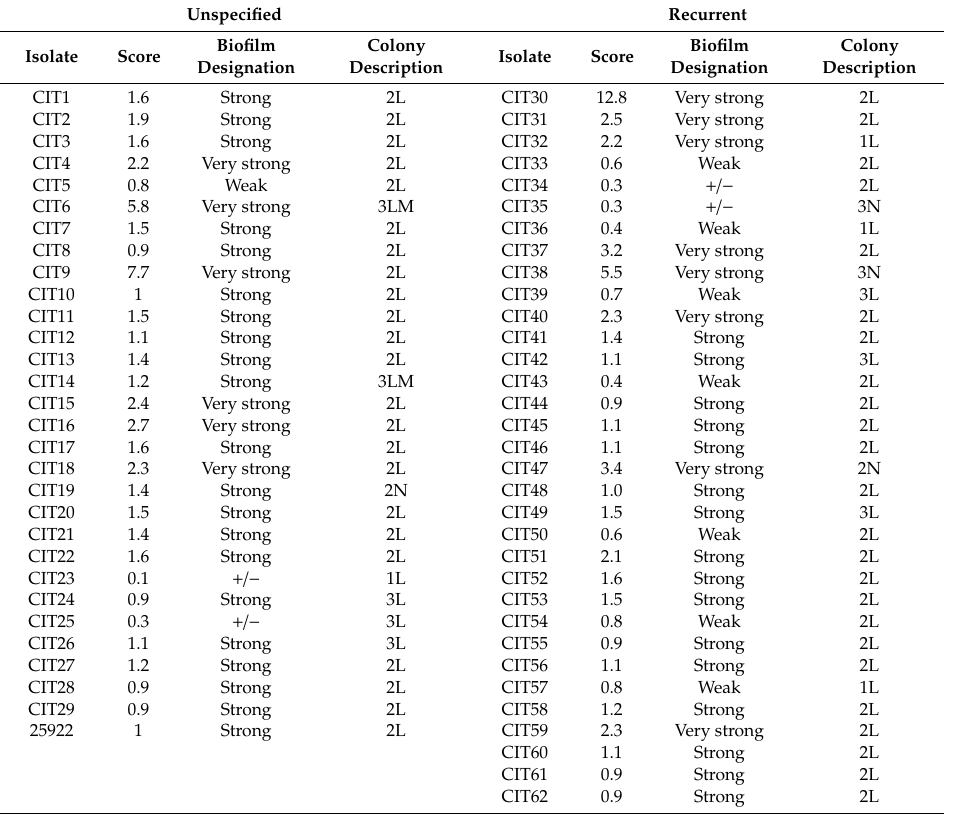
Table 1. Biofilm production expressed as a factor of the control organism E. coli ATCC 25922 with colony morphology